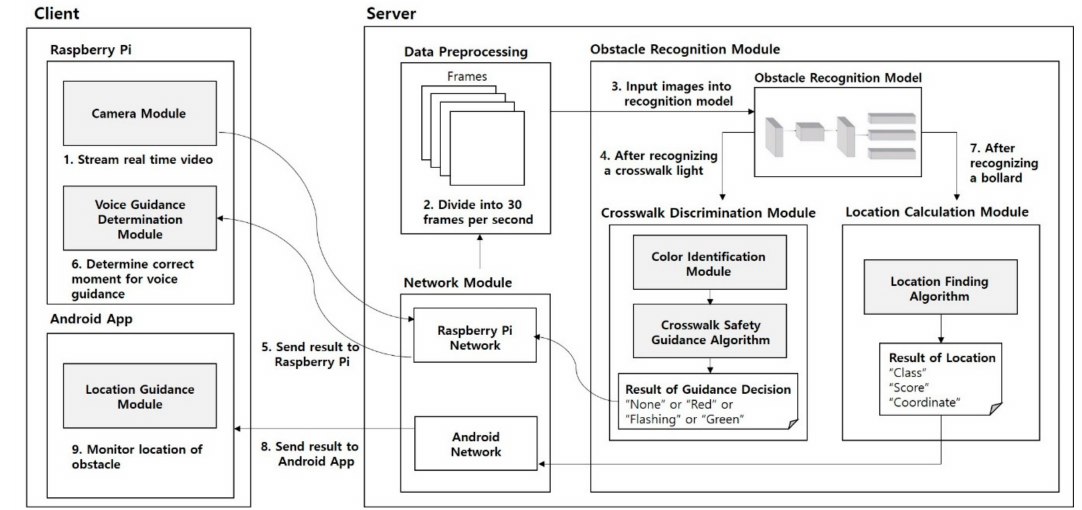
Figure 1. Architecture of obstacle recognition